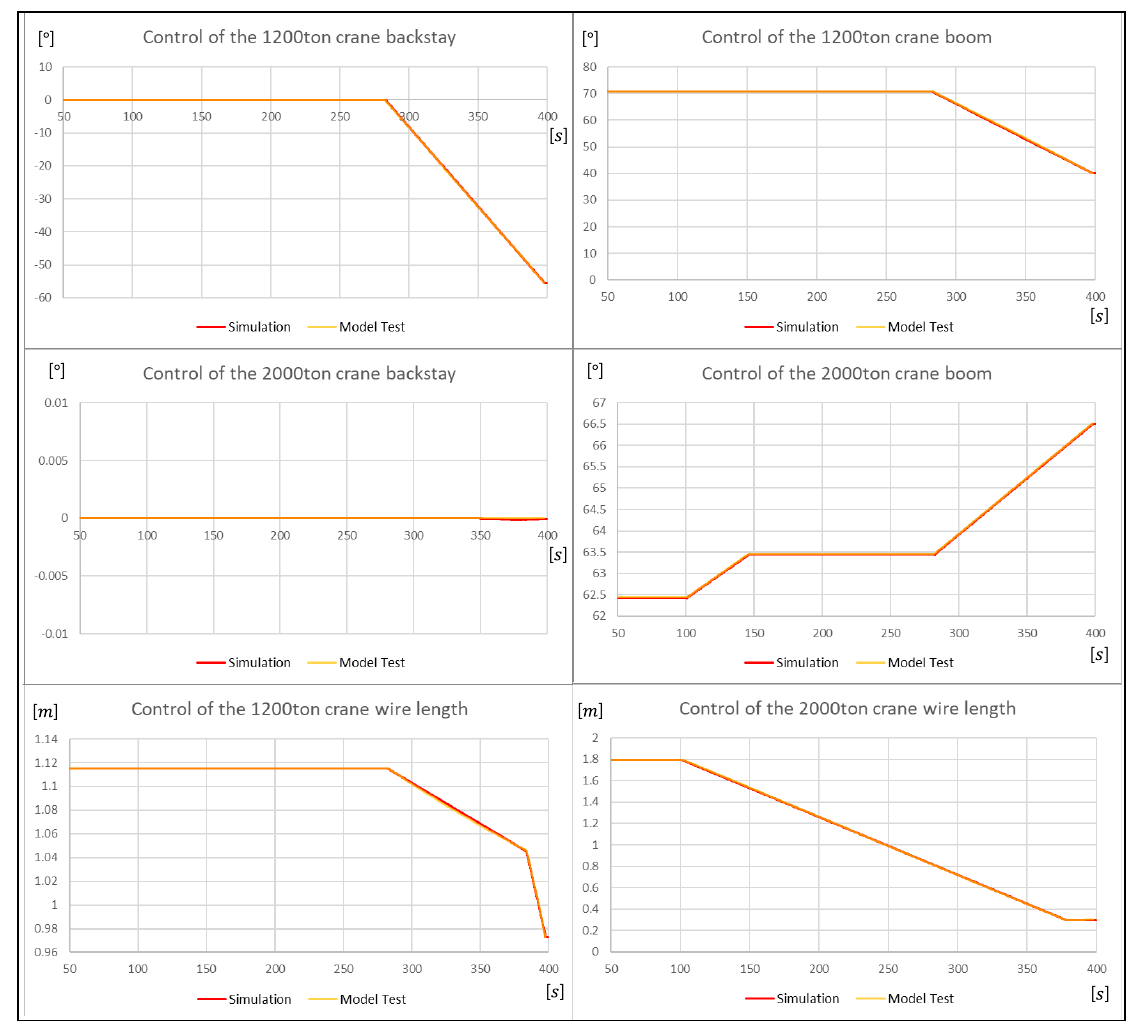
Figure 18. Comparison of model test and simulation control values.